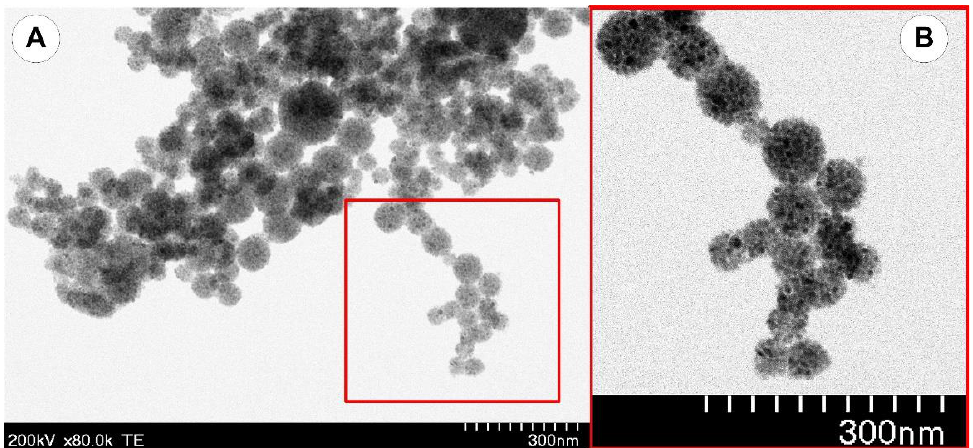
Figure 5. TEM image of the magnetic nanoclusters coated with PEG ( A ). Detail of the spherical clusters ( B